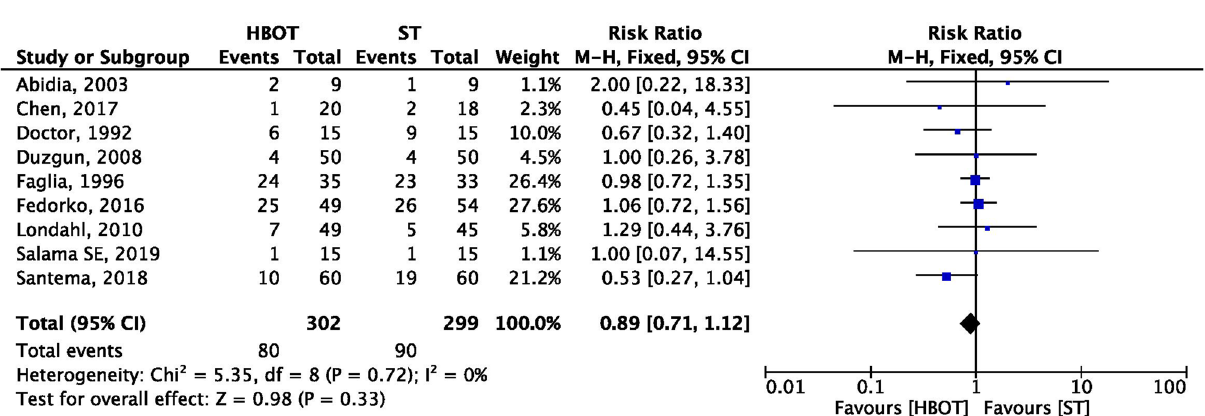
Figure 6. Forest plot of comparison: HBOT versus ST, Outcome: Minor Amputation.